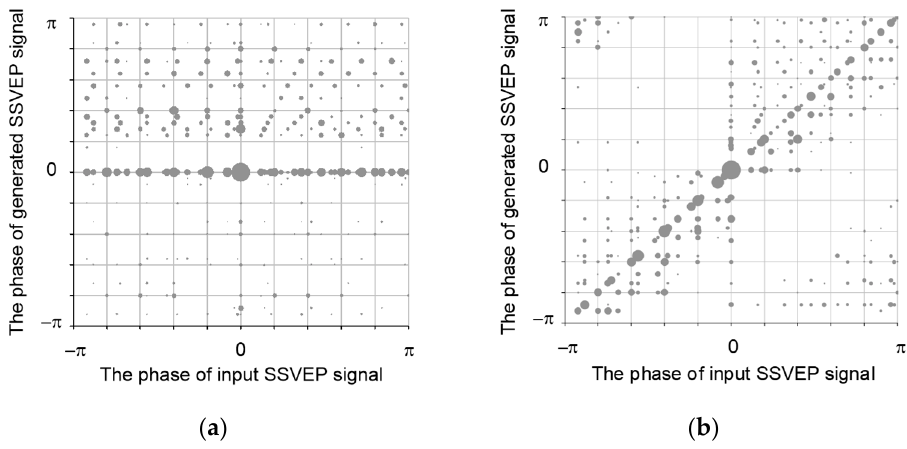
Figure 4. The phase information of enhanced SSVEP signal for ( a ) DAE_AP and ( b ) DAE_IP.